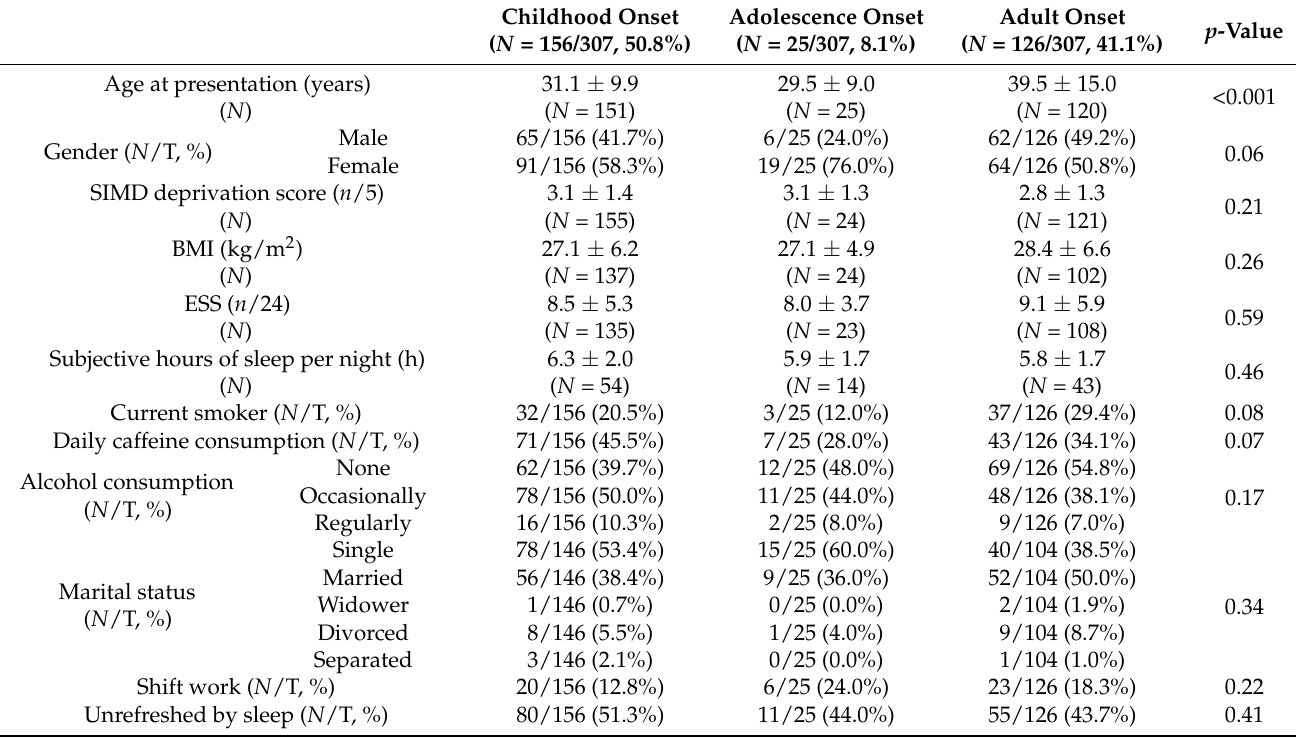
Table 1. Baseline characteristics of patients with NREM parasomnias split by age of onset (significance: p at 0.05/3 =